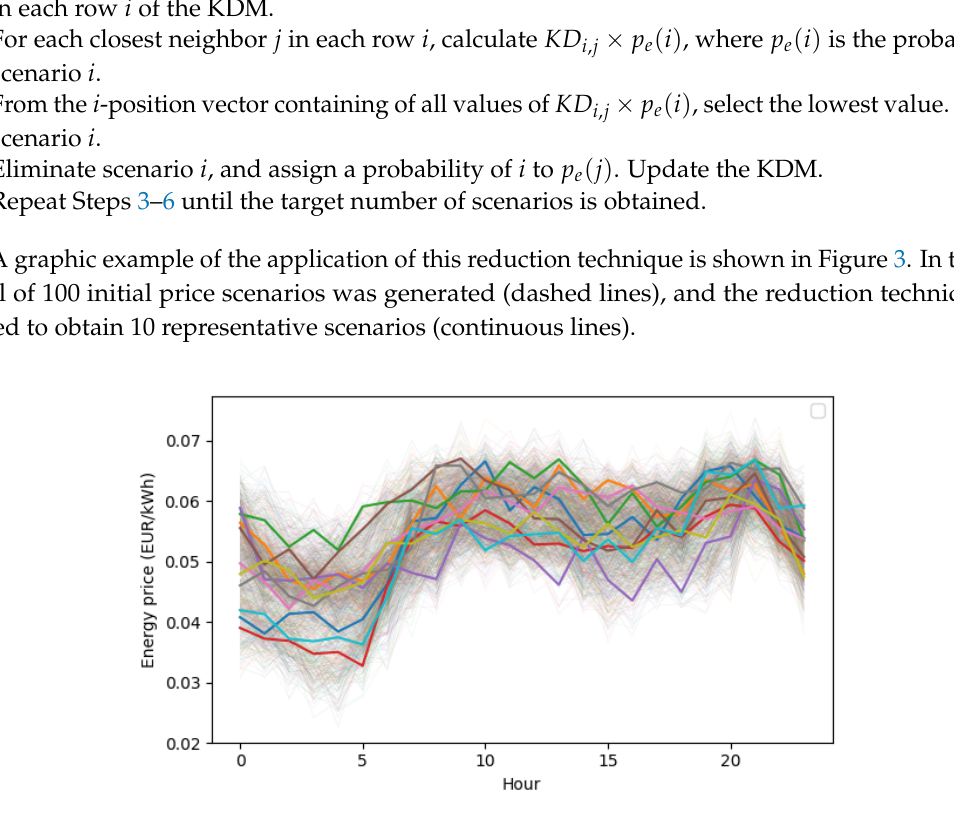
Figure 3. Example of Kernel Density Estimation (KDE) sampling and scenarios obtained after the backward reduction technique for energy